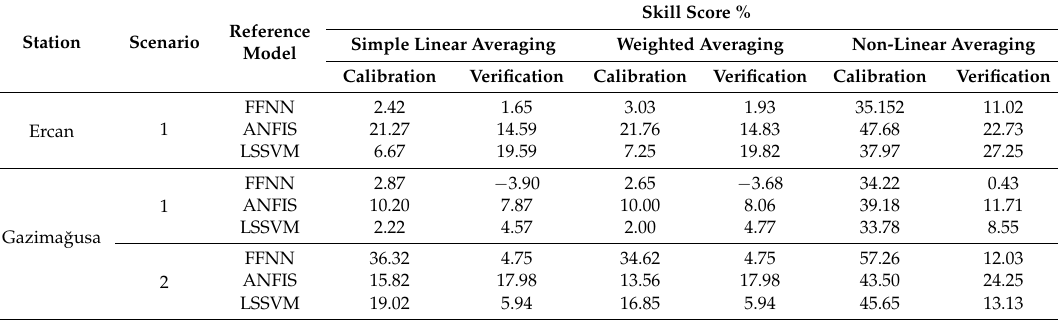
Table 9. Skill scores of ensembles using linear, weighted and non-linear averaging methods for scenarios 1 and